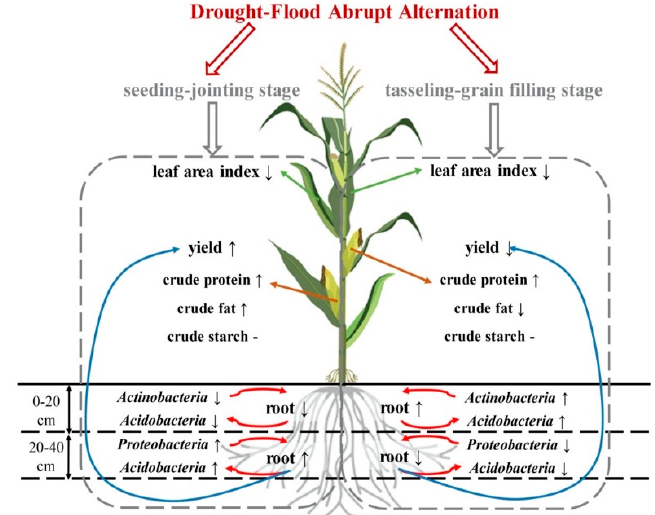
Figure 9. Mechanisms of the effects of DFAA on the growth of summer maize. The DFAA has different impacts on the summer maize growth when DFAA occurs in different growing periods. The leaf area index reduced under DFAA. The soil bacterial communities influenced the roots growth. The Actinobacteria and Proteobacteria had a positive correlation with the roots amount in the topsoil of 0–20 cm and 20–40 cm, respectively. Acidobacteria was more abundant with more healthy roots. When DFAA happened in the seeding-jointing stage, the roots reduced in the topsoil of 0–20 cm, while more roots were found in the topsoil of 20–40 cm. An opposite trend was observed when DFAA occurred in the tasseling-grain filling stage. The roots amount in the 20–40 cm had significantly positive impacts on the yield. The yield would increase with longer drought of the DFAA in the seeding-jointing stage, while it reduced in the tasseling-grain filling stage. DFAA would augment the grain crude protein content. The crude fat was obviously affected by the longer drought in the tasseling-grain filling stage. The DFAA had no apparent impacts on the crude starch content.